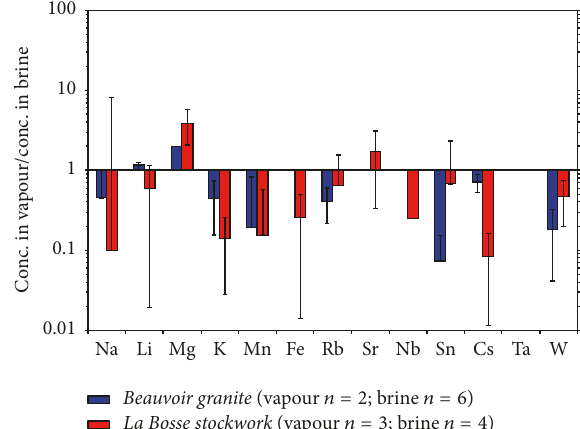
Figure 14: Vapour-brine distribution coefficients determined by LA-ICPMS analysis of coexisting V2- and L2-type fluid inclusions from the Beauvoir granite and the La Bosse stockwork. Columns represent the average value calculated for each fluid inclusion population, whereas error bars indicate the standard deviation (1 𝜎 ) associated with these